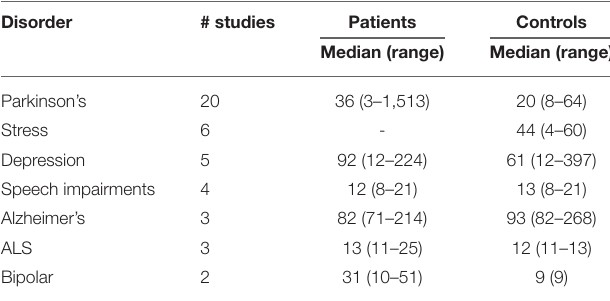
TABLE 1 | Overview of the included studies reporting on original (newly recorded) datasets from neurological disorders to provide a survey over emerging trends in the field. Figure 4B aggregates broad categories of analysis